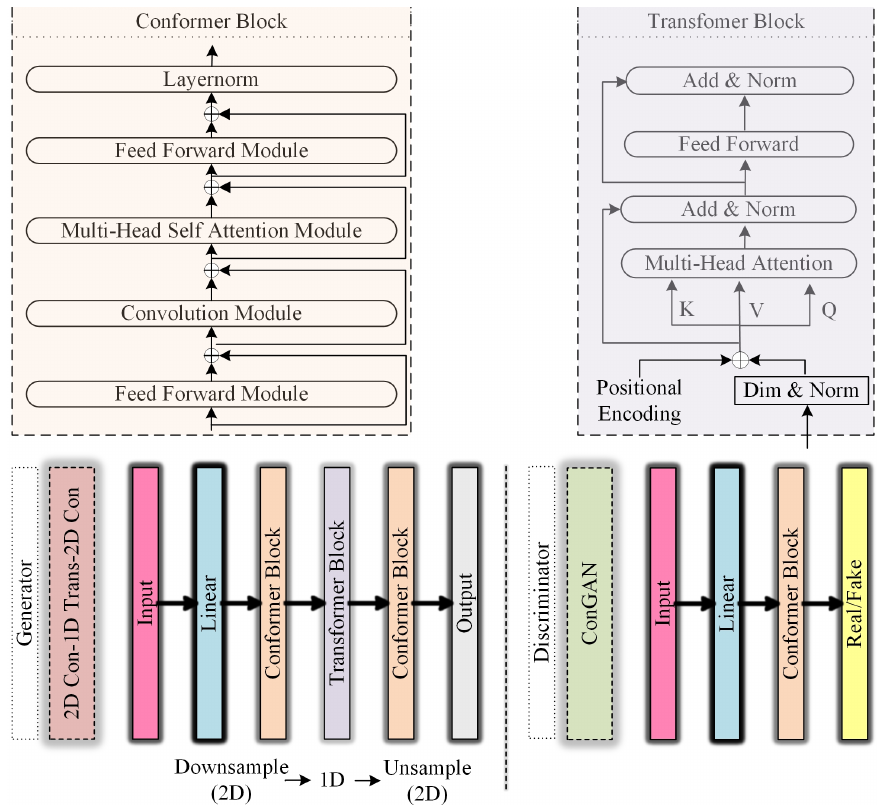
Figure 2. The architecture of CycleGAN including the 2D-Con-1D-Tran-2D-Con-based generator and 2D-Conformer-based discriminator.